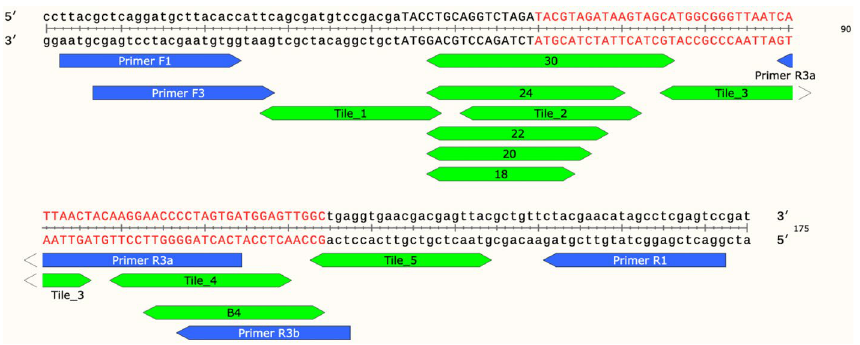
Figure 2. Template_0 target DNA and primer/LNA binding locations. The target oligonucleotide to be blocked (Template_0) includes a left primer region (1–43), a multiple cloning site (MCS) with SbfI, XbaI, and SnaBI sites (44–59), AAV2 sequence (4495–4558 in http:// www. ncbi. nlm. nih. gov/ nucco re/ AF043 303.1, 60–124, shown in red) and a right primer region (125–175). Two forward primer sequences on the left, F1 and F3, and three reverse primers on the right, R1, R3A, and R3B (blue arrows) were used to amplify the sequence with or without LNA blockers. Each LNA blocker (green double arrows) was made in four versions, two corresponding to the top strand (F, forward) and two corresponding to the bottom strand (R, reverse). The pair of F LNAs and the pair of R LNAs were synthesized starting with LNAs at either position 1 or position 2. These are listed individually in Table 2 and Table